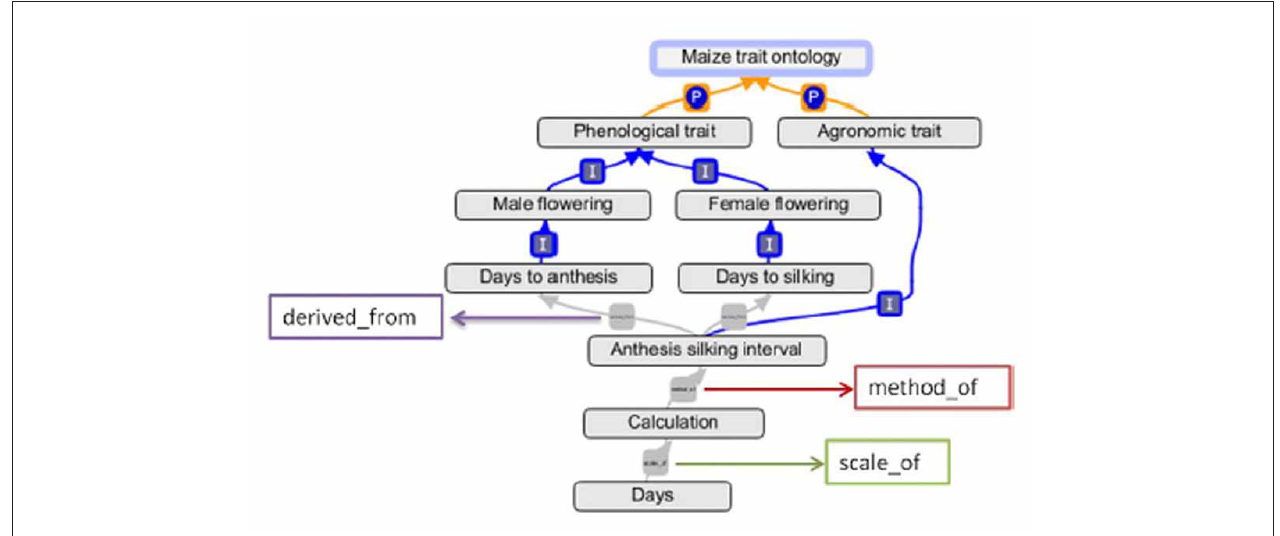
FIGURE 4 | Representation of the multi-relationships of “Anthesis silking interval” in OBO-Edit.